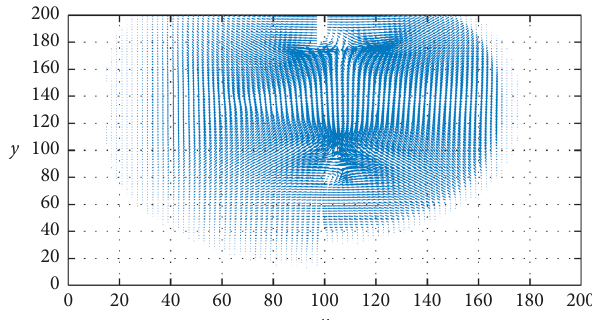
Figure 8: Velocity vector field of the partial dam-break problem at 7.2